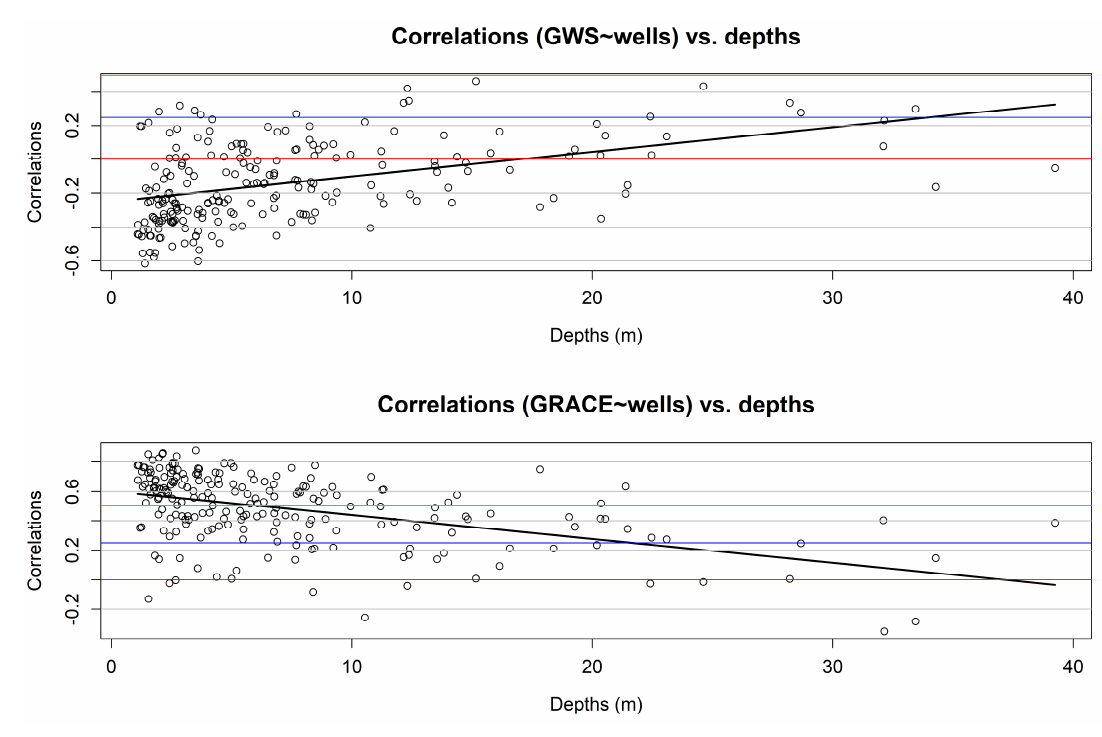
Figure 5. Correlations versus well depths: between GWS and the thickness of the unsaturated zone at the location of the well ( a ) and between GRACE and the thickness of the unsaturated zone at the location of the well ( b ).